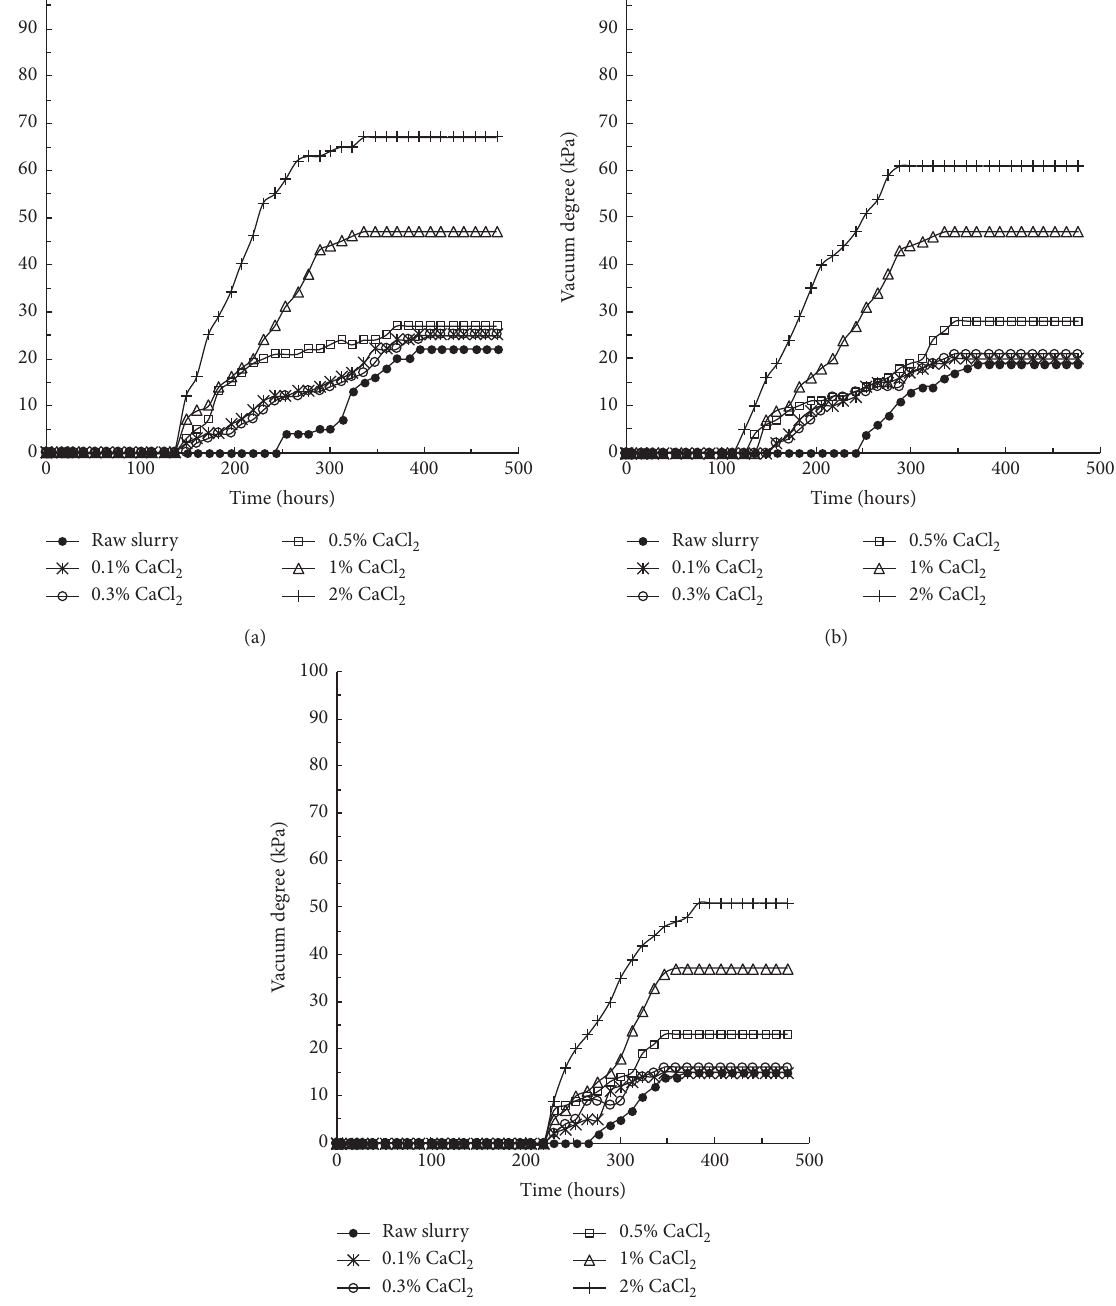
� 2 cm. (b) h � 6cm. (c) h � 2 . (a) h